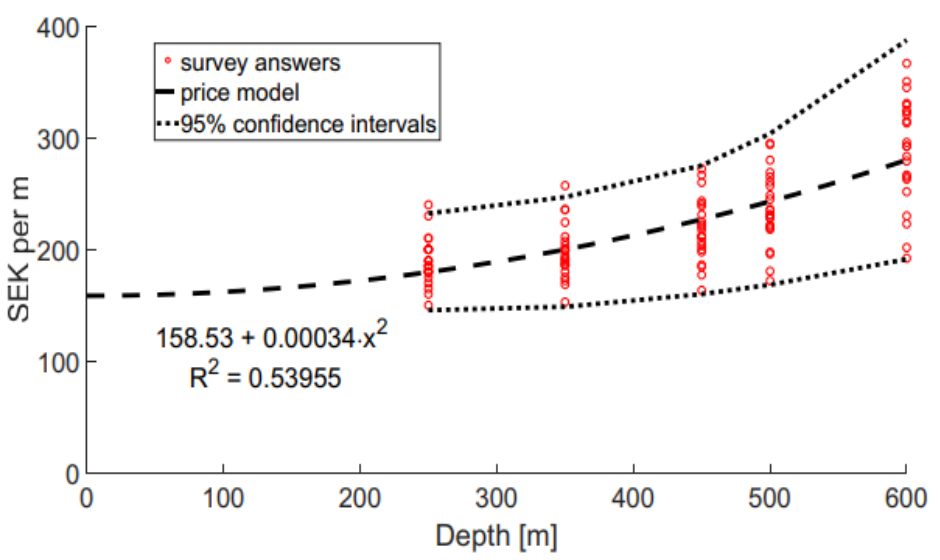
Figure 9. Depth-averaged drilling prices per meter for different borehole depths [48]. Electrical